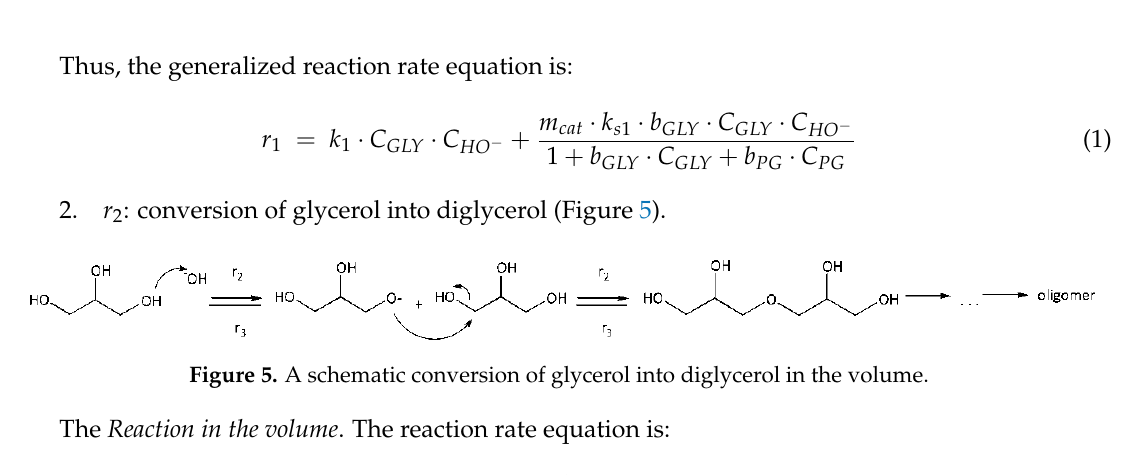
Figure 4. A schematic conversion of glycerol into lactic acid on the surface.